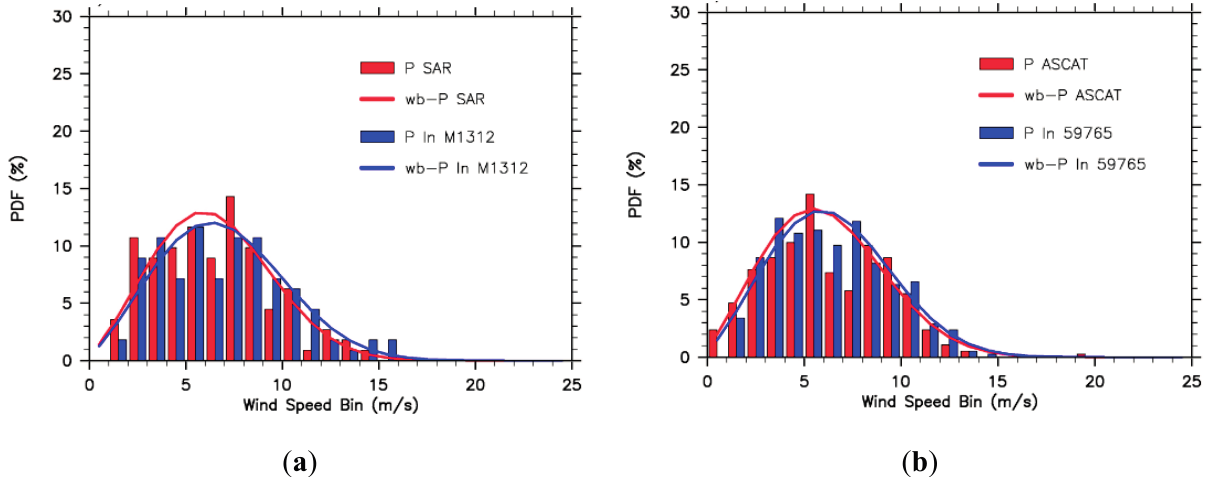
Figure 8. Histograms of in situ winds (red bars) and satellite retrieval winds (blue bars) as well as their Weibull fits (red curves for in situ winds and blue curves for satellite retrieval winds): ( a ) in situ winds and the co-located SAR winds at M1312; ( b ) in situ winds and the co-located ASCAT winds at